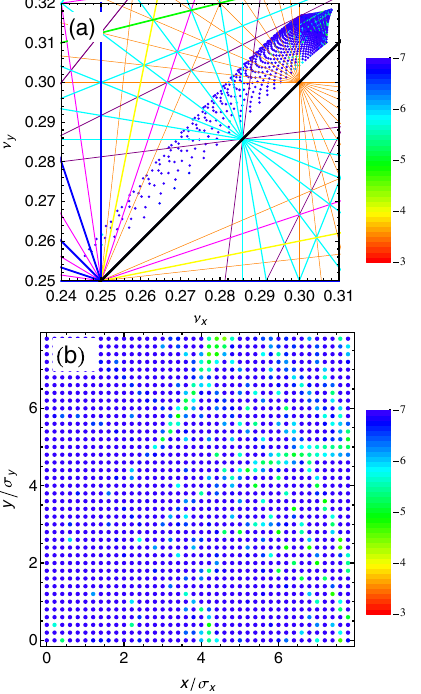
FIG. 2. Diffusion index in tune (a) and amplitude ( 0 − 8 σ ) (b) space for ð ν x ; ν y Þ ¼ ð 0 . 31 ; 0 . 32 Þ using the simple model.